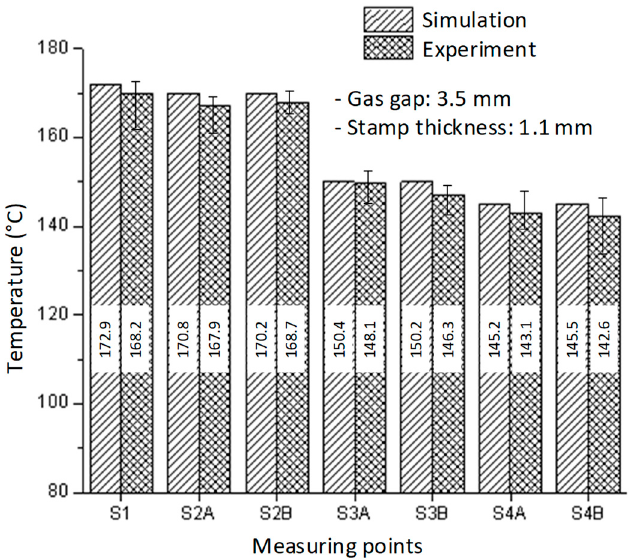
Figure 13. The comparison of temperatures in the simulation and experiment with a stamp thickness of 1.1 mm and gas gap of 3.5 mm.